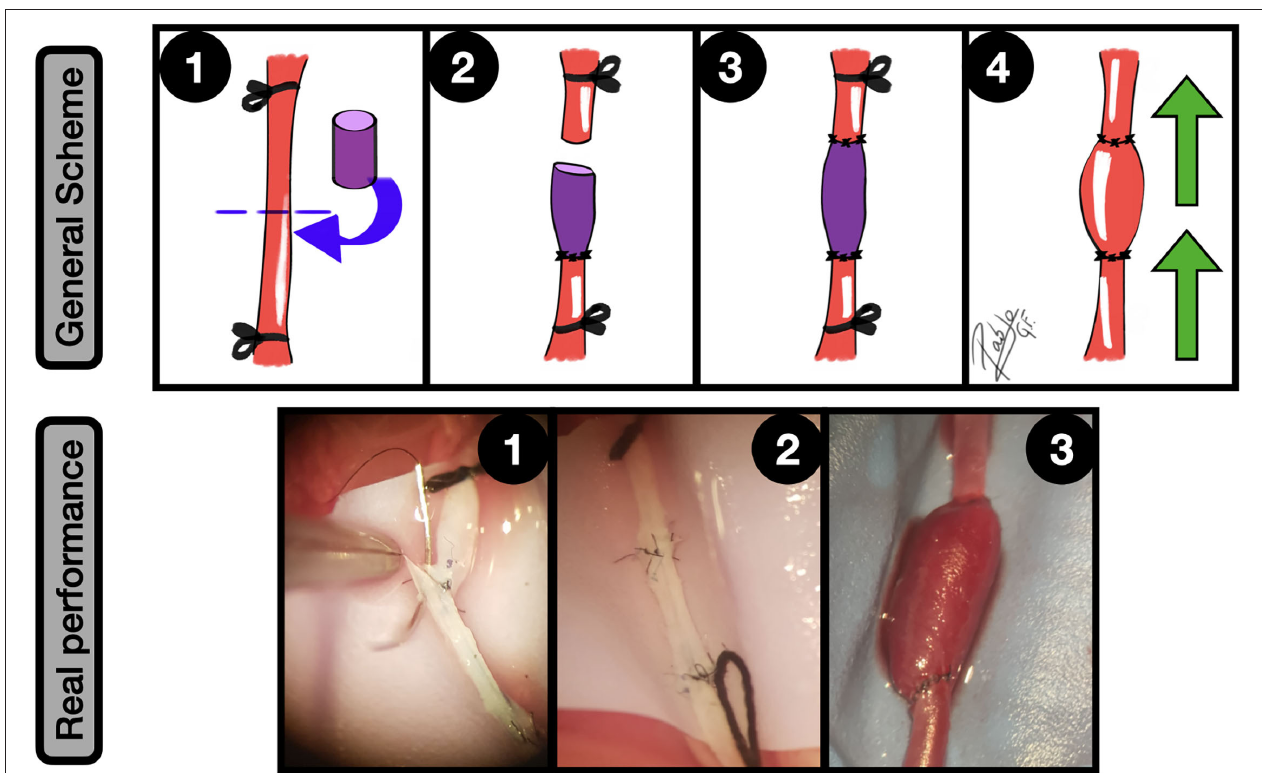
FIGURE 10 | Fusiform aneurysms. General scheme: 1: Unilateral CCA exposure and proximal and distal ligation. A straight arteriotomy in the middle of the artery is done and a free venous graft from a jugular vein is harvested; 2: One of the free lumens is sutured to the caudal CCA segment in an end-to-end fashion; 3: A second end-to-end anastomosis is made between the graft and the proximal CCA, acting as an interpositional venous graft; 4: The clamps are released and the flow inflates the venous segment of the construction, obtaining a fusiform aneurysm. The green arrows indicate the blood flow direction. Real performance: 1: Suturing between CCA proximal segment and the free venous graft; 2: The second end-to-side anastomosis is completed, observing the interpositional venous graft; 3: After releasing the clamps the blood flow enlarges the venous segment of the construction, simulating a fusiform